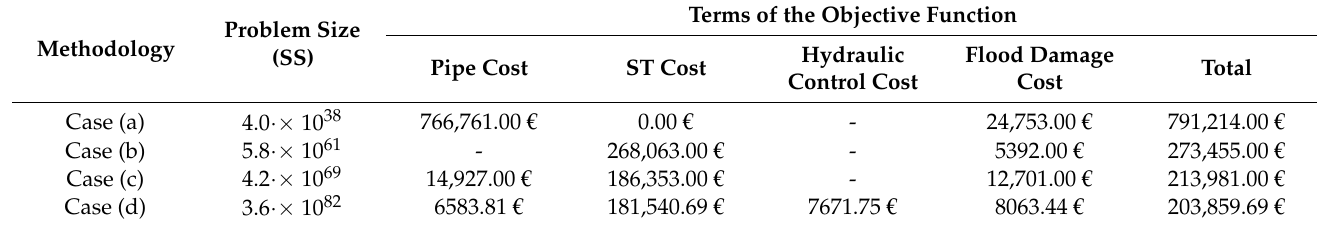
Table 8. Comparison of the objective